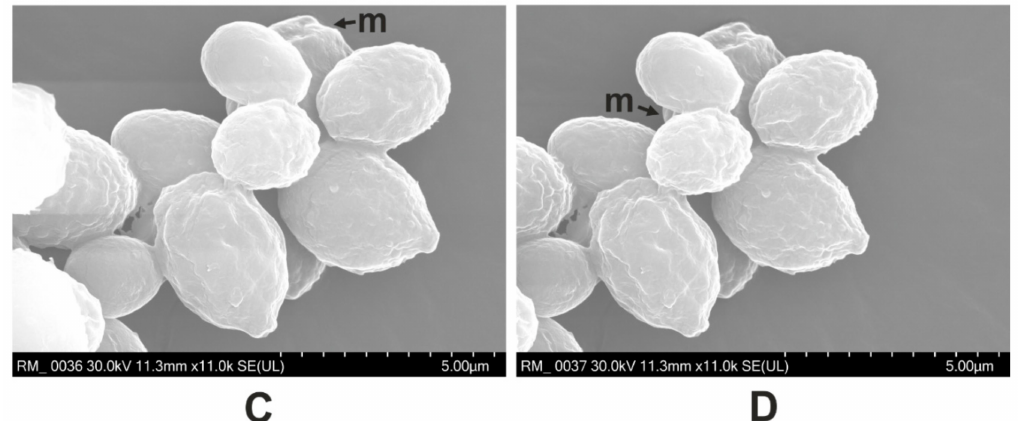
Figure 2. Scanning electron micrographs showing M. guillermondii ( A , B ) and R. mucilaginosa ( C , D ). Legend: b, bud; c, cell; m, mucilage; ph,